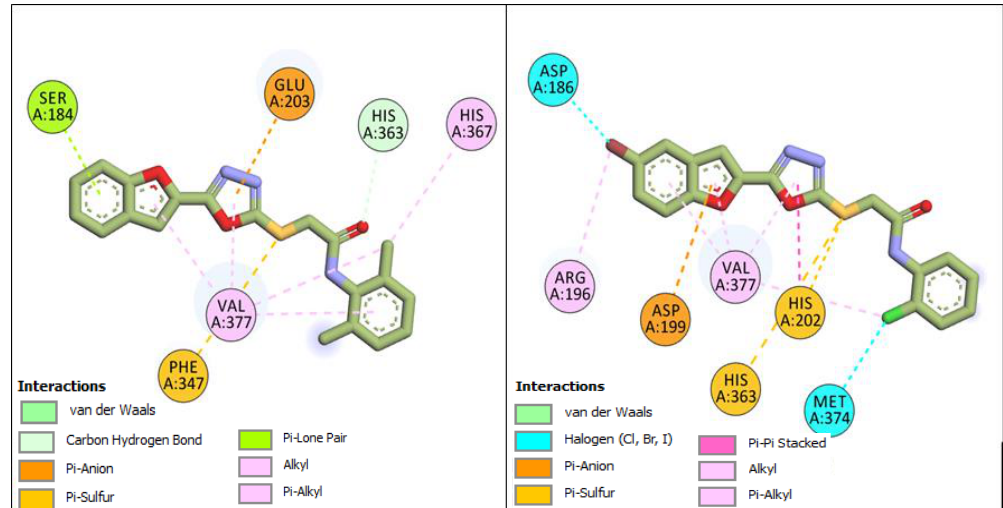
Figure 6. Two-dimensional conformational pose of BF7 with hTyrosinase ( Right panel ) and two- dimensional conformational pose of BF15 with hTyrosinase ( Left panel ).